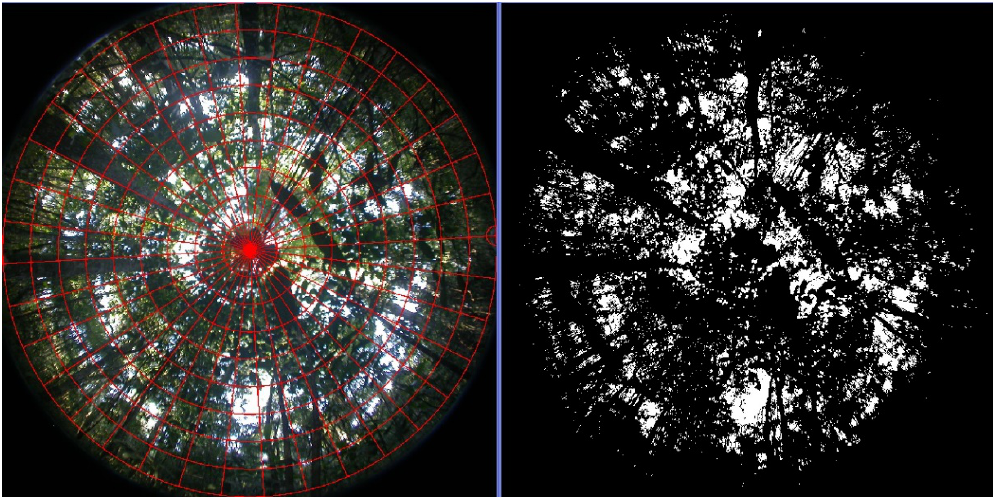
Figure 4. Hemispheric image from the plot area. Left image displays the geometric adjustment grid for lens distortions. The image on the right shows the product of high contrast processing for classification of areas with leaf coverage (black) and sky (white).